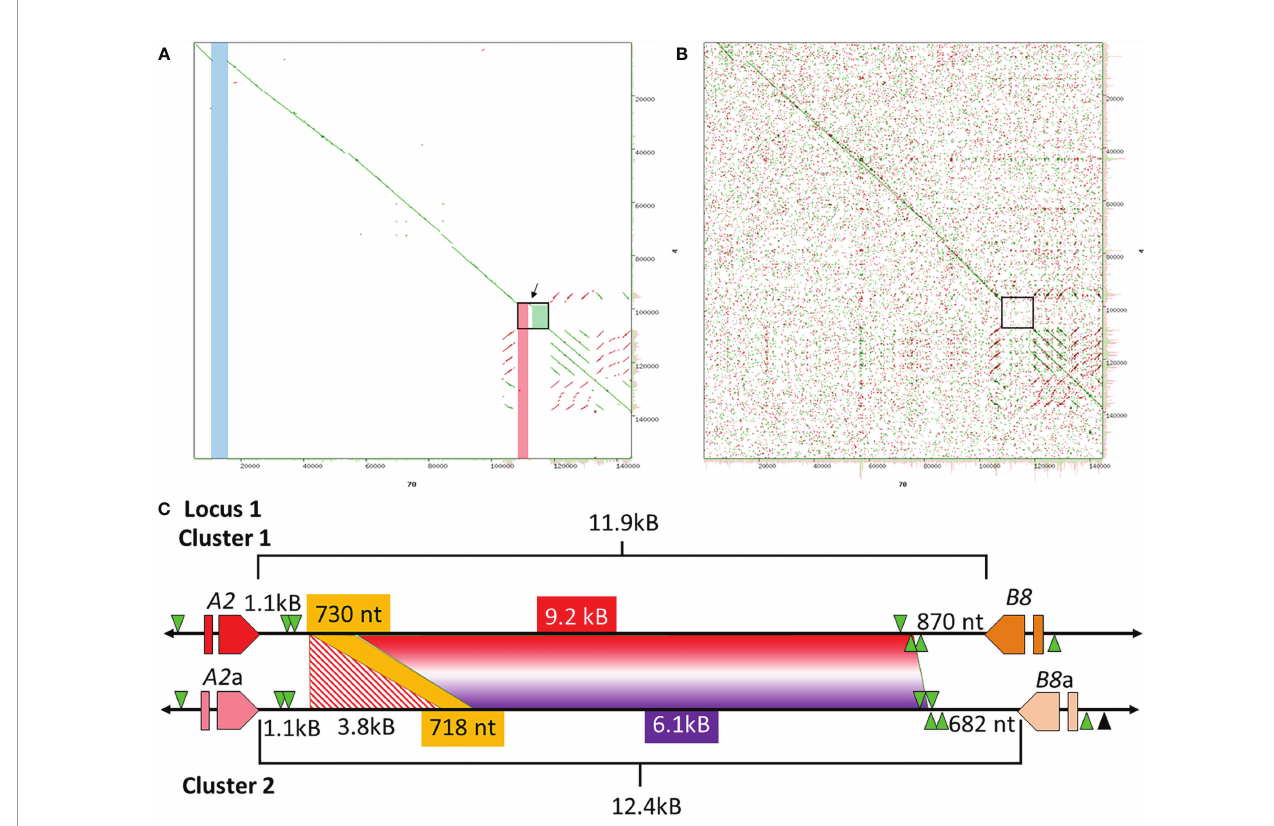
FIGURE 2 | The IGRs of Clusters 1 and 2 in Locus 1 include non-matching sequences. (A, B) Dot plots show the comparison between Cluster 1 and Cluster 2. The dot plot in (A) employed a preset e-value threshold of 10 whereas the dot plot in (B) employed an e-value threshold of 10,000. The central diagonal in the dot plots indicate the mostly identical sequence of the allelic regions, while lines offset from the central diagonal indicate repeats that are highly similar in either a tandem (green) or inverted (red) orientation. Highlighted, colored vertical bars in (A) indicate the locations of mismatched sequences between the two clusters. The blue and red bars show the locations of sequences in Cluster 2 that are absent from Cluster 1 and the green box indicates a region of complete dissimilarity. The arrow between the red bar and green box in (A) indicates a region of similarity that is located between the two regions of dissimilarity. The black boxes in (A, B) are expanded in (C) to show details. YASS 8 was used to generate dot plots with standard parameters (scoring matrix = +5, -4, -3 -4: composition bias correction: gap costs = -16, -4: X-drop threshold = 30). (C) The IGRs located between the A2/ a and B8/ a genes in Clusters 1 and 2 are a mixture of similar and dissimilar sequences. The red and orange polygons indicate the SpTrf genes, A2 /a and B8 /a genes, that fl ank these IGRs. GA STRs (green triangles) surround each gene. The horizontal black line indicates the DNA that extends from the 5 ʹ and 3 ʹ ends of each gene. The lengths of the IGRs between the A2/ a and B8/ a genes are indicated by upper and lower brackets. The sizes of the areas within the IGRs are indicated by colors that are coordinated when similar. The red and white striped region is a sequence that is only present in Cluster 2 and corresponds to the red bar in (A) . The yellow region is a short area of similarity, and the area of complete dissimilarity is shown as a polygon of a red and purple gradient. This fi gure in not drawn to